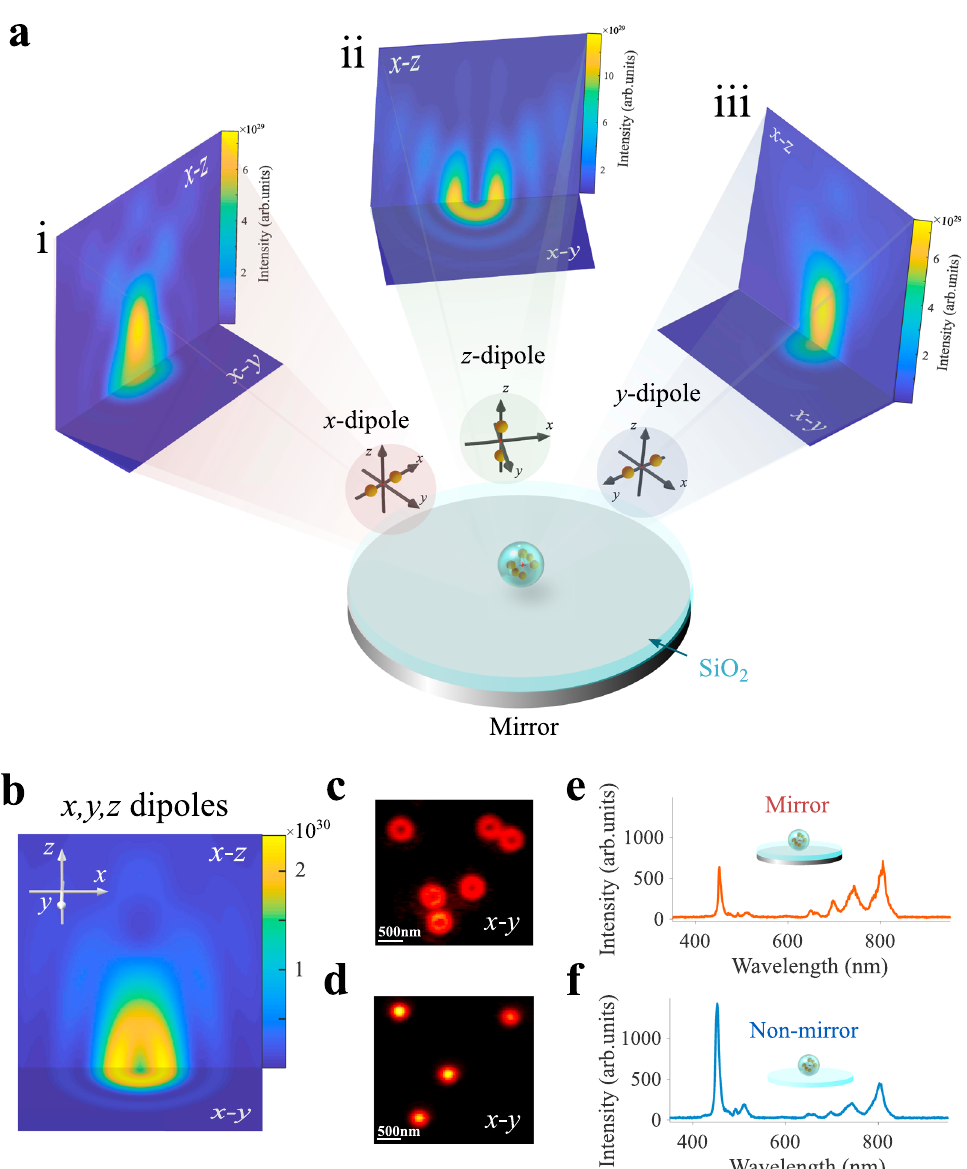
Fig. 1 Spatial self-interference of UCNPs on a mirror substrate. a A single UCNP is placed on a mirror substrate with a silica layer as the spacer. Calculations of self-interference of dipole emitters with different orientations on a mirror substrate were performed with a fi nite element Maxwell ’ s equation solver (JCMwave) for a SiO 2 spacer layer with a spacing of 154.9 nm. (i), (ii), and (iii) show different cuts through the far- fi eld PSFs of self- interference patterns of oriented dipoles oscillating along the x , y , and z -axis, respectively. The horizontal two-dimensional cuts are for x - y planes with z = 0 (dipoles ’ centre). The vertical cuts are for x-z planes with y = 0 (dipoles ’ centre). The emission wavelength in simulation is 455 nm. b The total emission fi eld from the self-interference fi eld of x -, y -, and z -dipoles. In the simulation for a and b , the origin ( x = 0, y = 0, z = 0) of the coordinate system is in the centre of the UCNP, while the Ag mirror is located 154.9 nm below the origin. Experimentally, the weights of the self-interference fi eld of x -, y -, and z - dipoles will be modi fi ed by the effective numerical aperture of the imaging collecting system, which has been considered in the simulation. c Wide fi eld fl uorescence image of UCNPs in the con fi guration with a UCNP-to-mirror distance (spacing) of 154.9 nm. d Wide fi eld fl uorescence image of UCNPs on a cover glass surface. The wide fi eld fl uorescence image of UCNPs is fi ltered through a blue color fi lter (475 ± 12.5 nm). A defocused 980 nm laser creates the wide fi eld excitation. The scale bar in c and d is 500 nm. The measured emission spectrum from a single UCNP on e a mirror substrate with a spacing of 154.9 nm and f a cover glass surface. The UCNPs used in the experiment are β -NaYF 4 :20%Yb 3 + ,8%Tm 3 + , with a diameter of 33 nm. The size of UCNPs is characterized by transmission electron microscopy, as shown in Supplementary Fig. 2. (Further details on the synthesis and characterization of UCNPs as well as fabrication of the mirror substrate are provided in Supplementary Information Note 2). The spectra are measured by a single-particle characterization system described in detail in ref. 44 (see Supplementary Fig. 14 for the details of the emission the distance increases, the PSF changes periodically from intensity variations). constructive to destructive interference. Figure 2a ii – f ii , g ii – l ii Figure 2a i – f i , g i – l i shows the numerical simulation of PSF at shows the experimental results of measured PSFs. These the x-y plane ( z = 0) and the y-z plane ( x = 0), respectively. The experimental results qualitatively match the numerical simula- nanoparticles locate at the measuring focal plane where z = 0. As tion, further con fi rming our interpretation of nanoscale SELFI.